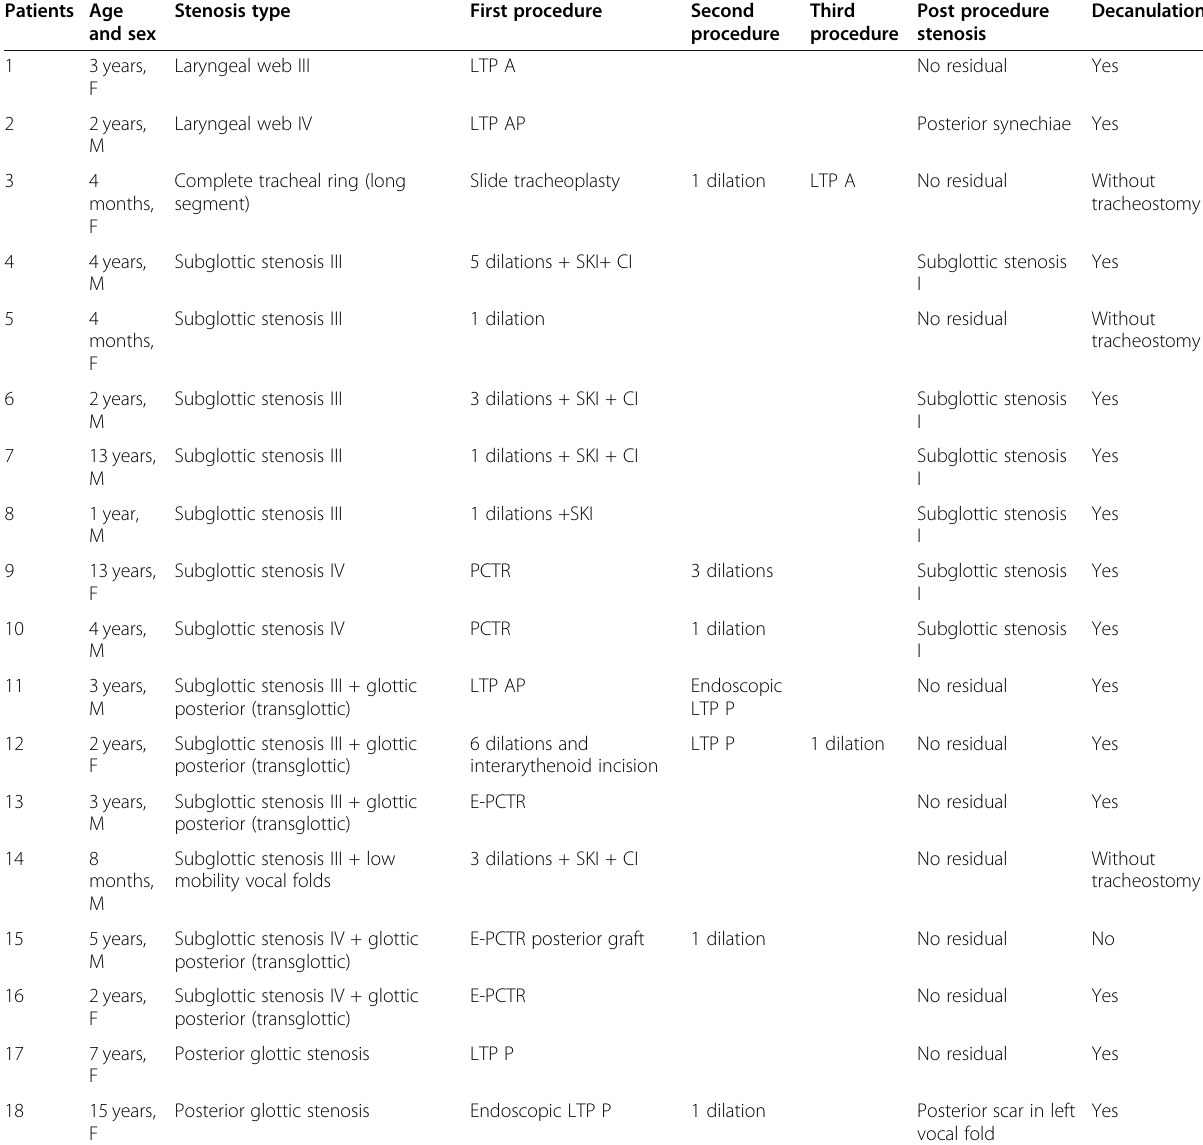
Table 1 Patients with complex laryngotracheal stenosis Patients Age Stenosis and sex